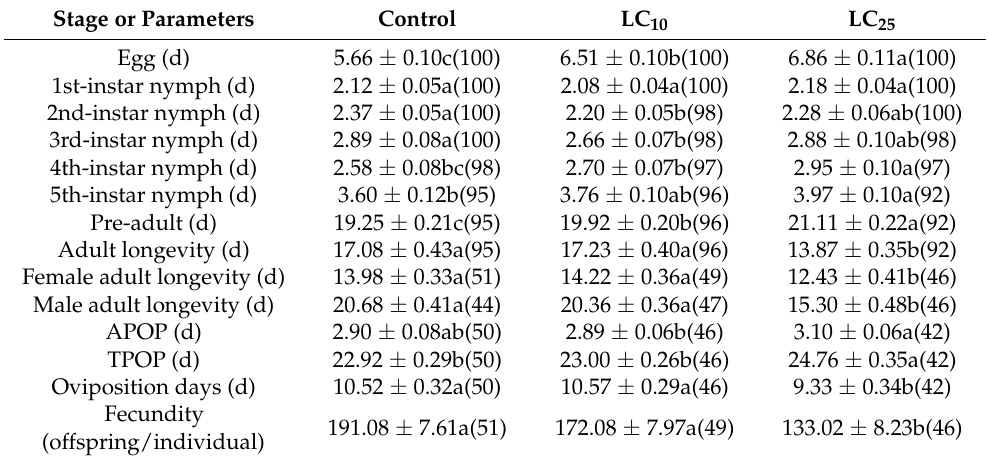
Table 3. The effects of sublethal concentrations of Beauveria bassiana BEdy1 on the development duration, longevity and reproductive parameters of the F 1 generation of Sogatella furcifera . Stage or Parameters